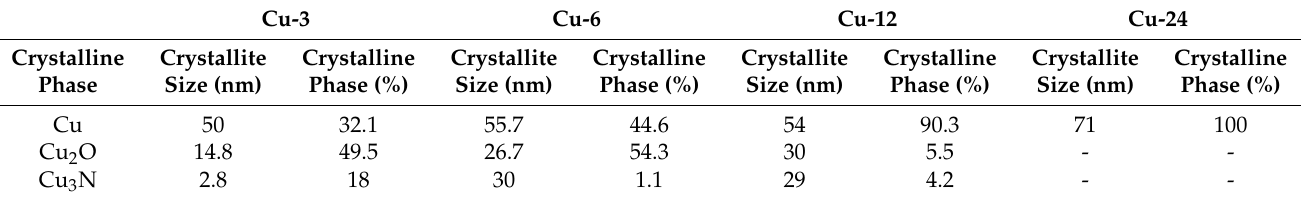
Table 1. Phase ratios of Cu 2 O, Cu 3 N and Cu in the samples and their crystallite size distribution calculated from the PXRD